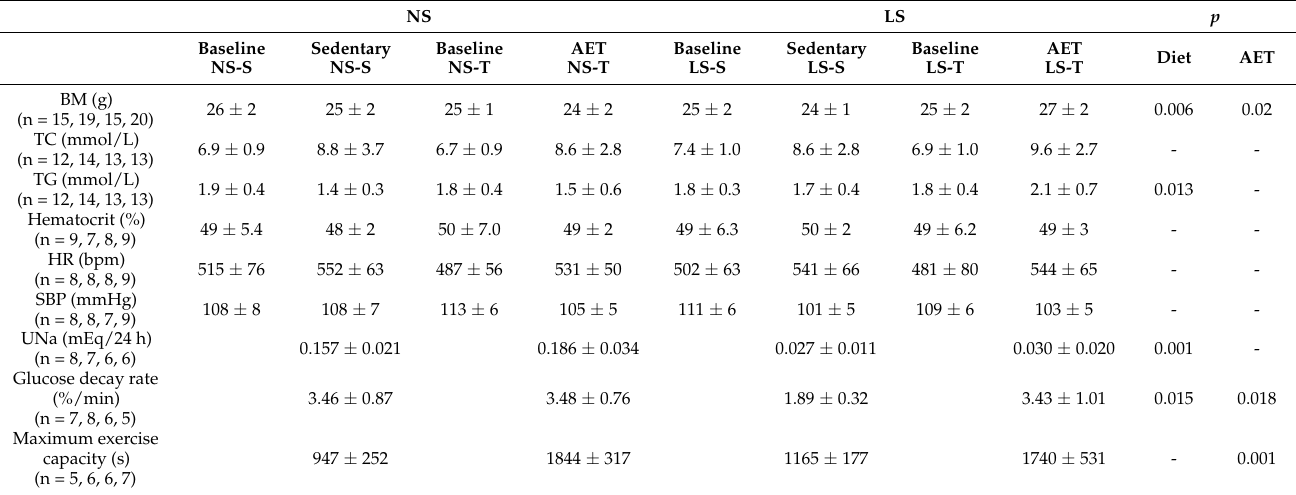
Table 1. Body mass, biochemical plasma, hematocrit, heart rate, blood pressure, urinary sodium, and exercise capacity of LDLR KO mice fed either a normal-sodium (NS) or a low-sodium (LS) diet, trained (T) or sedentary (S), at baseline and after 90 days. NS